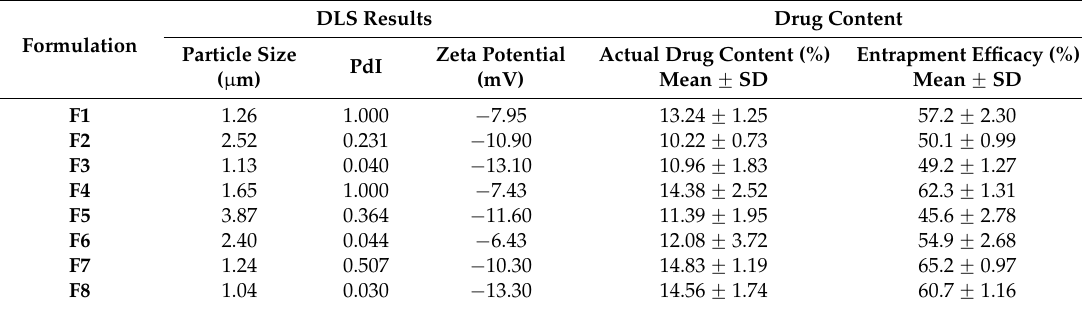
Table 2. DLS characterization and drug content of AL-loaded